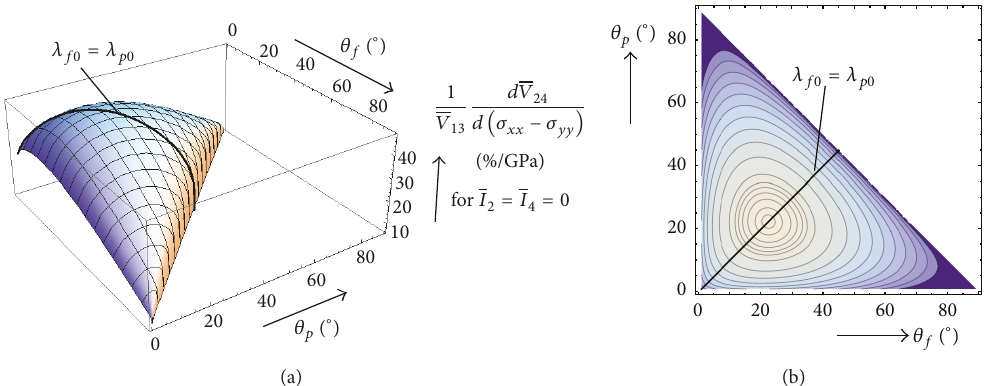
Figure 13: Sensitivity of output voltage 𝑉 24 versus mechanical stress 𝜎 𝑥𝑥 − 𝜎 𝑦𝑦 (normalized to supply voltage 𝑉 13 ) for a circular device of Figure 12. All other components of the stress tensor vanish, as well as 𝜎 𝑥𝑥 + 𝜎 𝑦𝑦 = 0 . The plots are graphical representations of (26b), (28b), (28c), (18a)–(18i), and (19b) in the limit of small stress and with the piezoresistive coefficient 𝜋 44 = 1.381/ GPa for low p-doped silicon. Largest stress sensitivities are obtained for contact size 𝜃 𝑓 = 𝜃 𝑝 = 22.5 ∘ with a flat maximum. The black curve denotes offset-free devices with 𝜆 𝑓0 = 𝜆 𝑝0 at zero stress; they are the only ones, where 𝑉 24 = 0 at zero stress. The black curve goes through the maximum of the surface. The contours in (b) are for 48.25, 48, 47.5, 47, 46.5, 46, 45, 42.5, 40, ... , 22.5, 20%/GPa. In (a) the steep slopes of the surface near 𝜃 𝑓 < 1 ∘ and < 1 ∘ are only sketched due to numerical 𝜃 𝑝